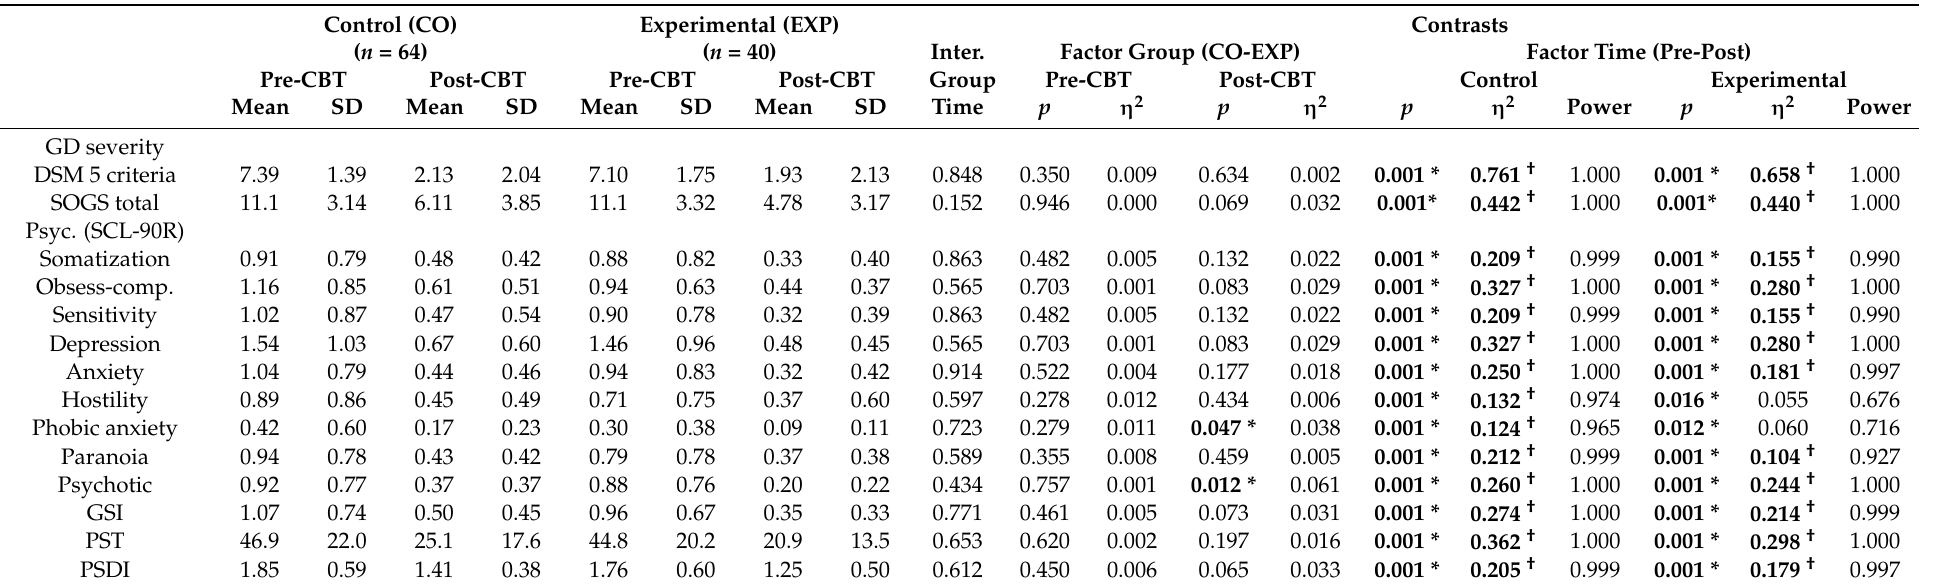
Table 2. Pre-post changes registered for the CBT: 2 × 2 mixed ANOVA. Control (CO) Experimental